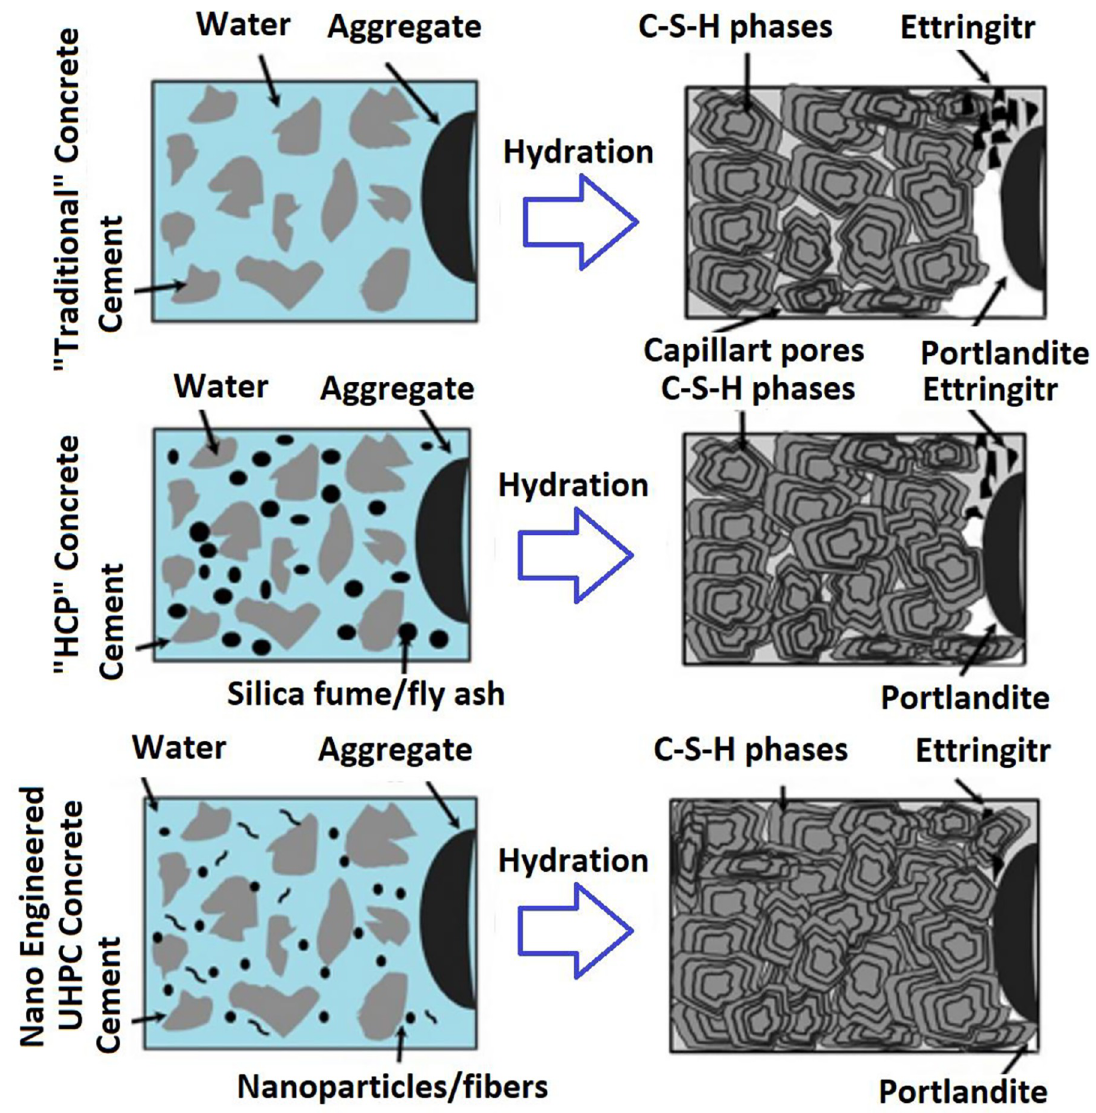
Fig 1. Traditional, high performance and nano-enhanced UHPC